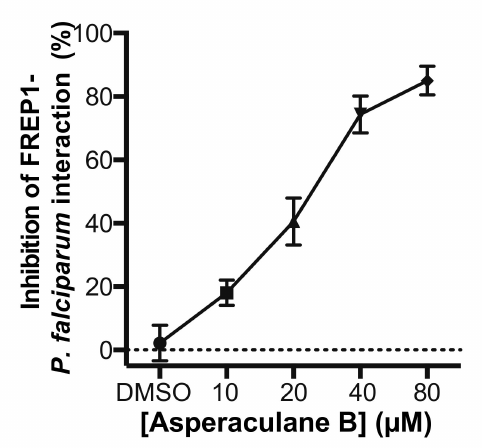
Figure 9. Asperaculane B prevented FREP1 proteins from binding to P. falciparum -infected cell lysate determined by